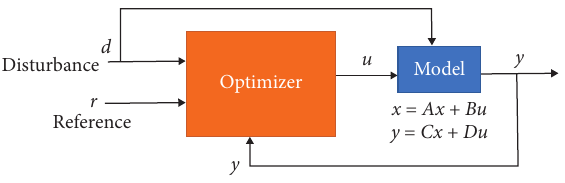
Figure 7: Model predictive control